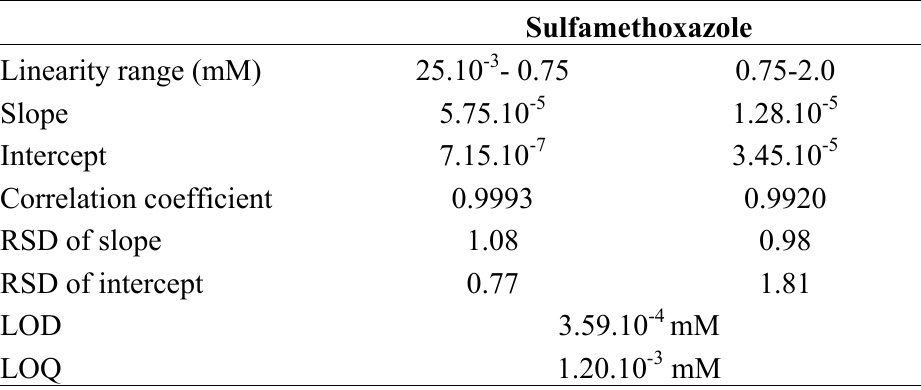
Table 1. Characteristics of sulfamethoxazole calibration